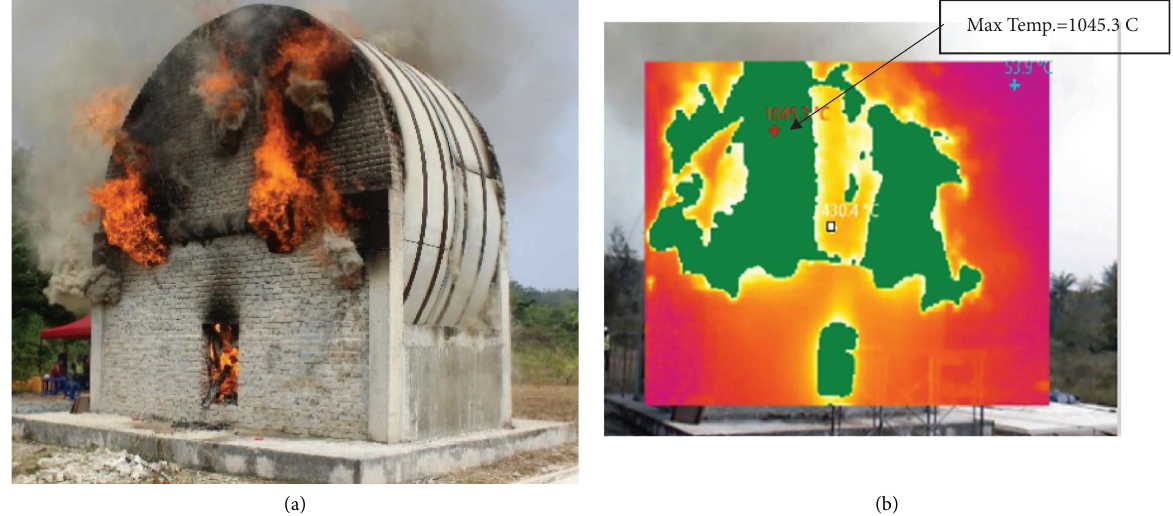
Figure 2: Te tunnel ring fre test (a) during the peak fre at 15minutes and (b) infrared photos for maximum temperature.